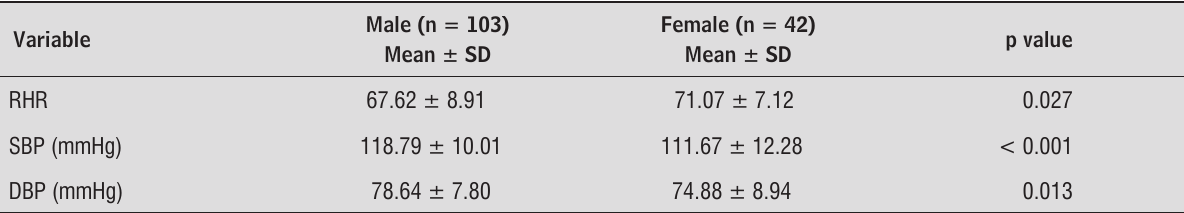
Table 1 - Characterization and comparison of the physical fitness and health components of professors at UFV, according to sex